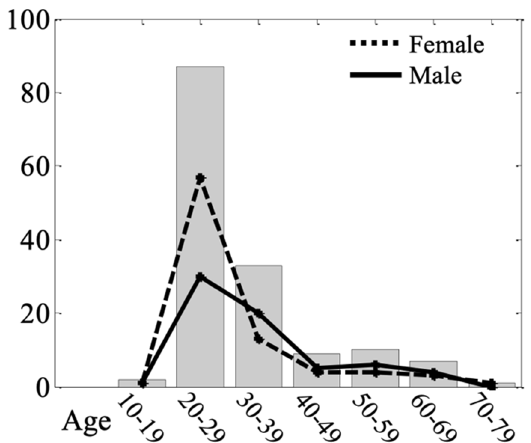
Figure A1. Frequency distribution of age and its break-down by sex.